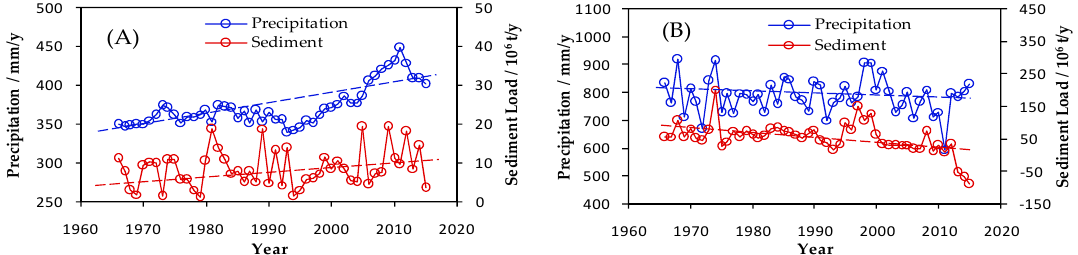
Figure 4. Comparison of ( A ) annual average precipitation and ( B ) sediment load from 1966 to 2015.